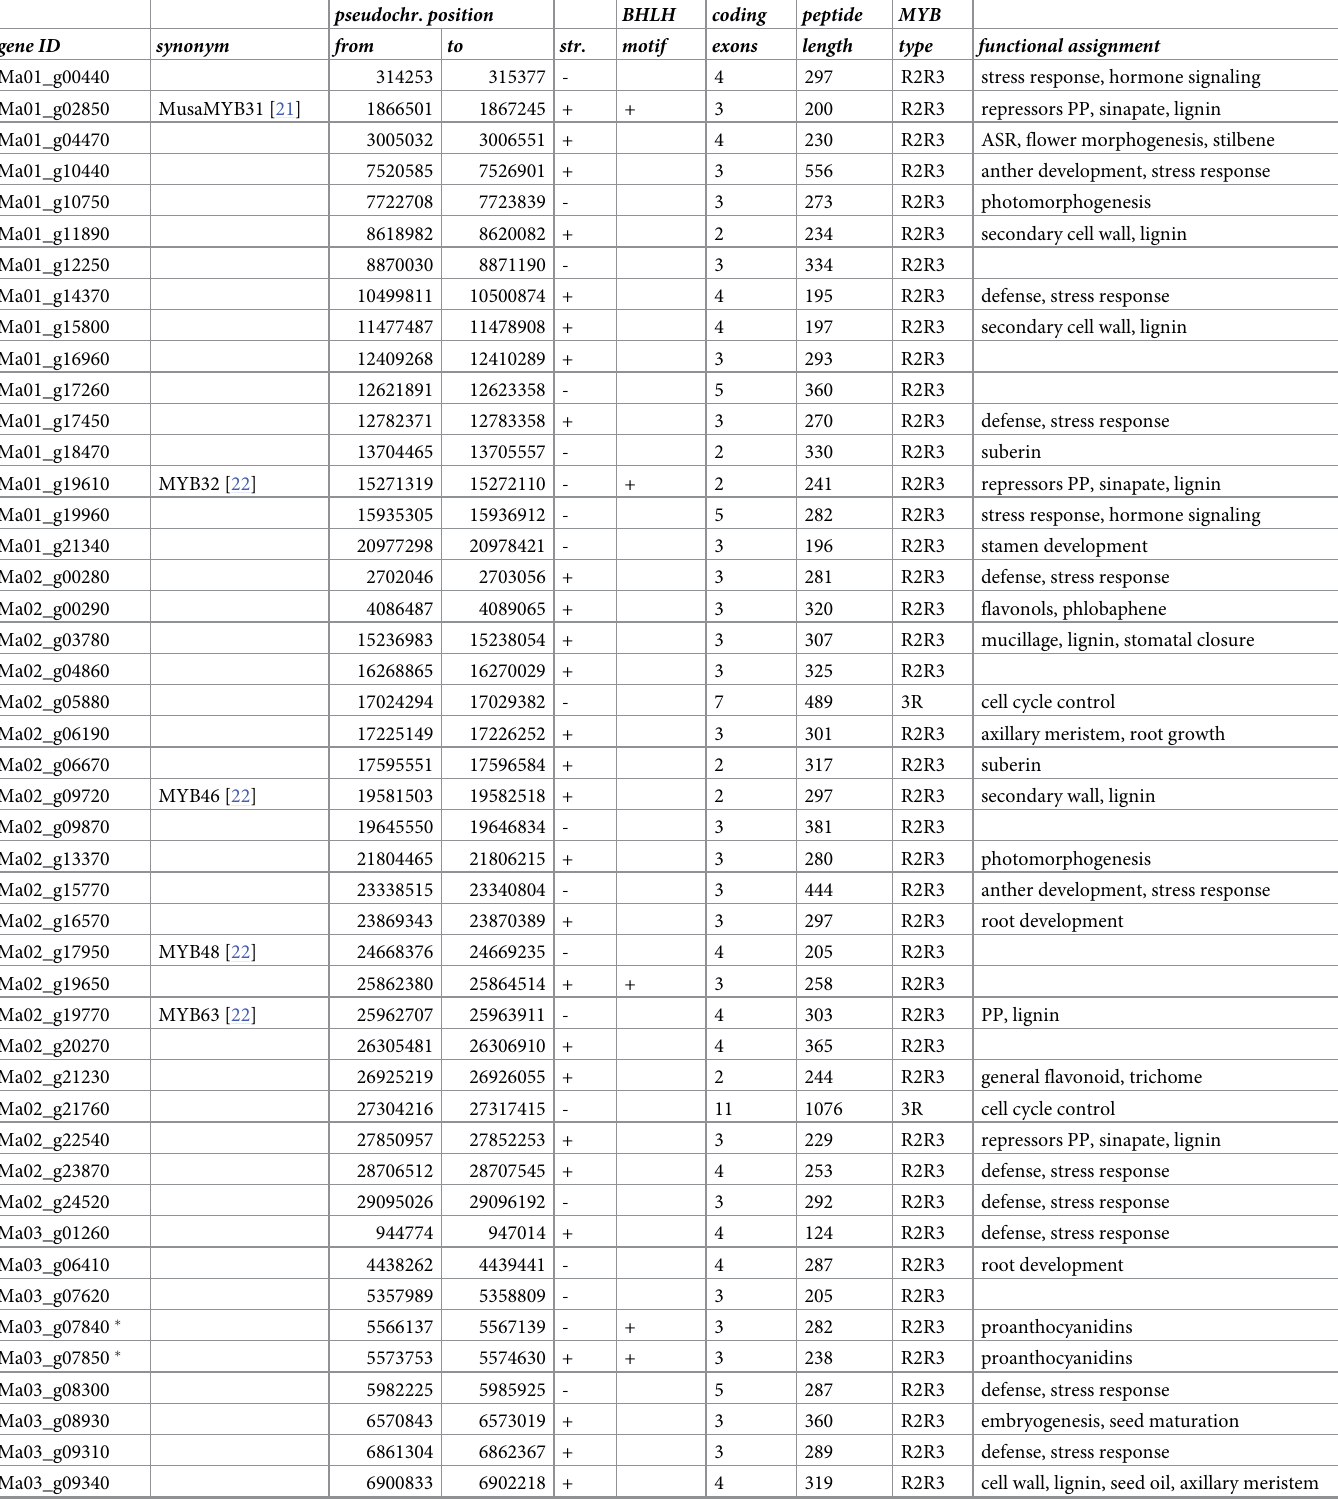
Table 1. List of annotated MYB genes in the Musa acuminata (DH Pahang) genome sequence. pseudochr .